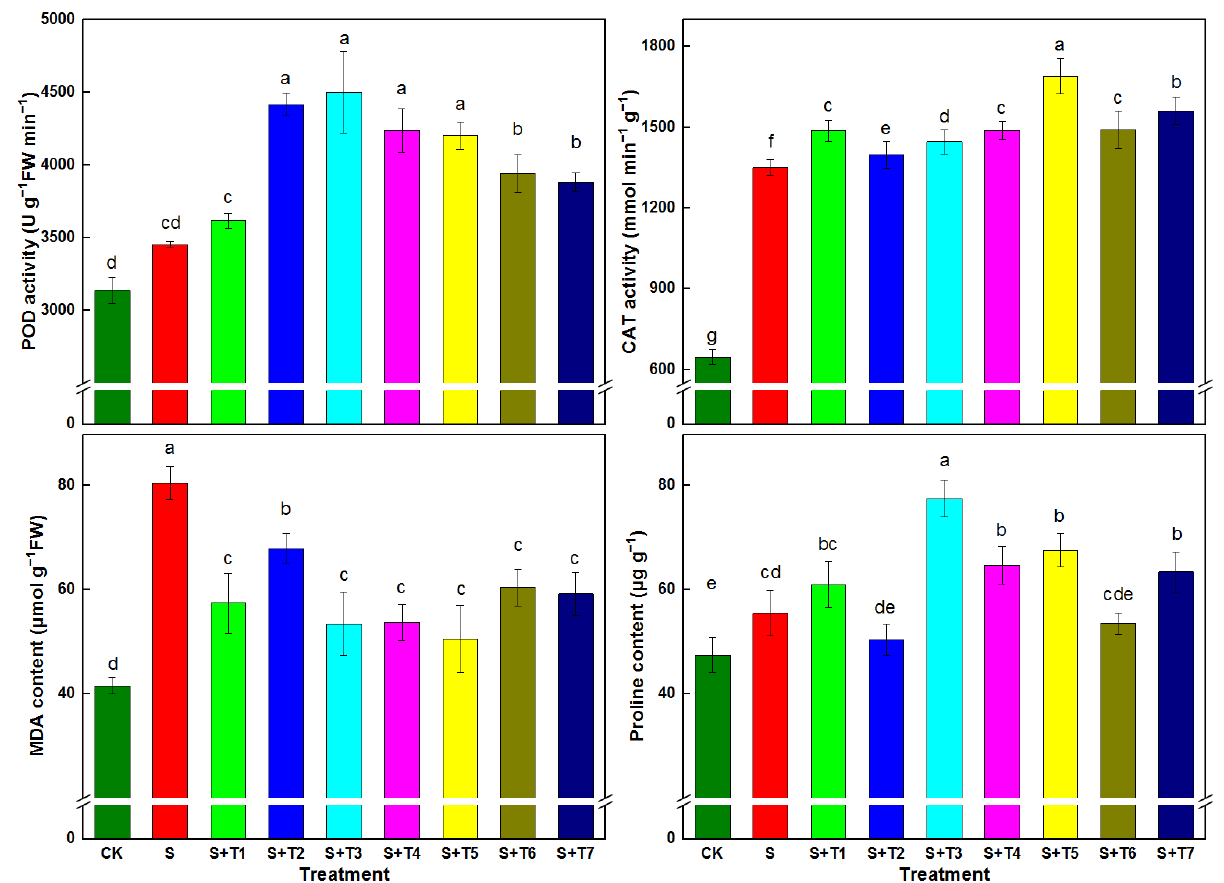
Figure 2. Effects of EBR spraying on POD and CAT activity and MDA and proline content in